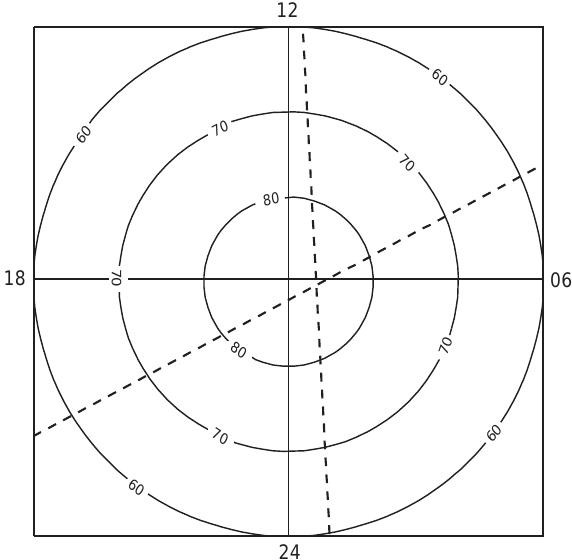
Fig. 1. Polar cap subdivided into several regions by satellites orbits. Boundaries, at which F and @ U =@ n are assumed to be known, are satellites trajectories ( thick dashed lines ) and low latitude boundary of the polar cap ( thick solid line )